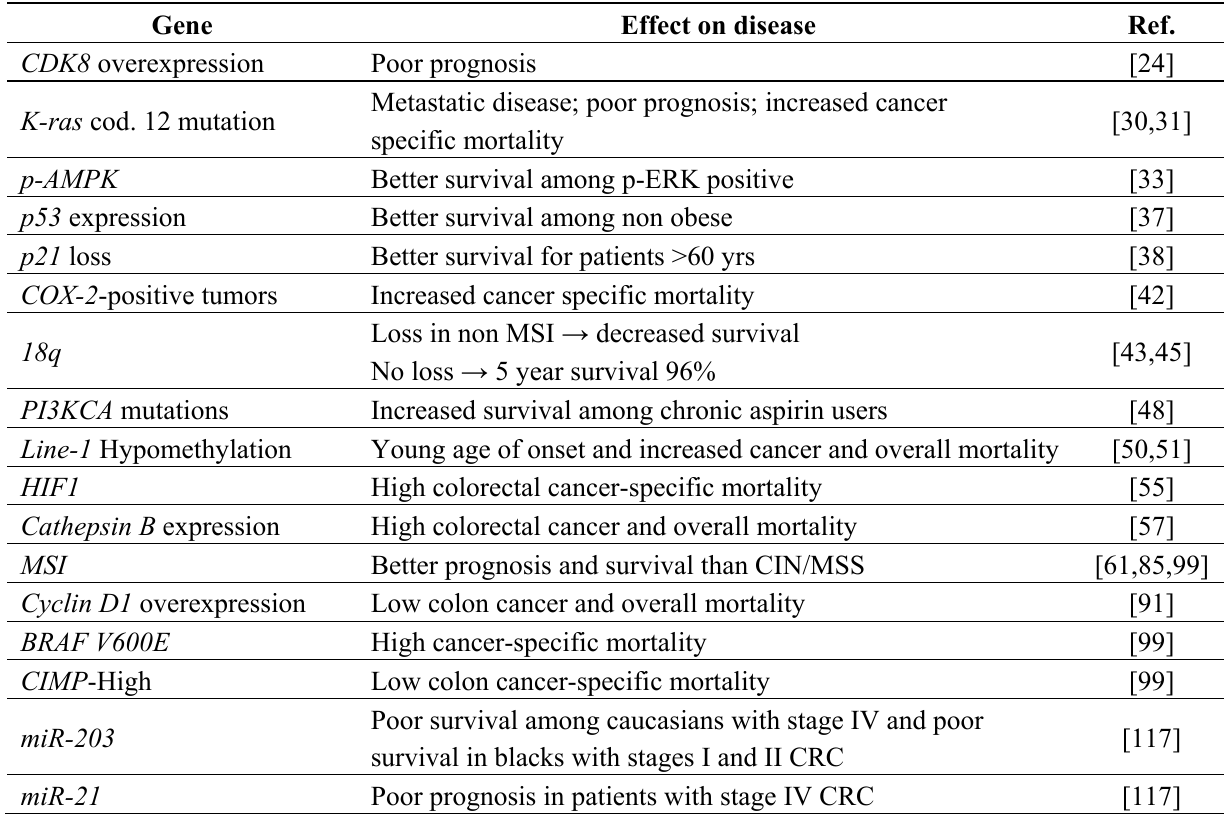
Table 1. Molecular markers and implications for disease behavior. Gene Effect on disease